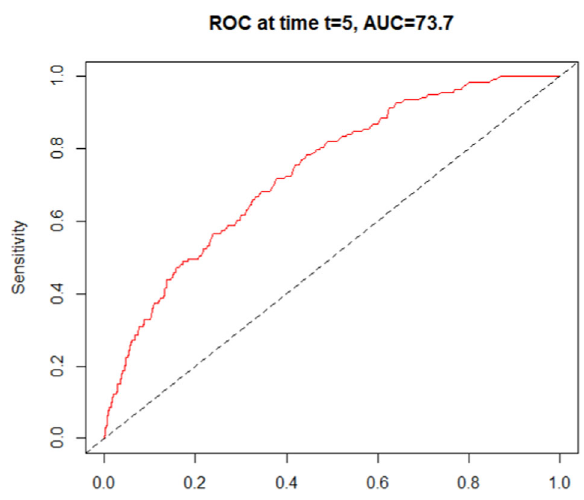
Fig. 3 Discriminatory accuracy of PREDICT represented by the area under the receiver-operator characteristic (ROC) curve at the 5-year timepoint in the overall population. ROC receiver-operator characteristic, AUC area under